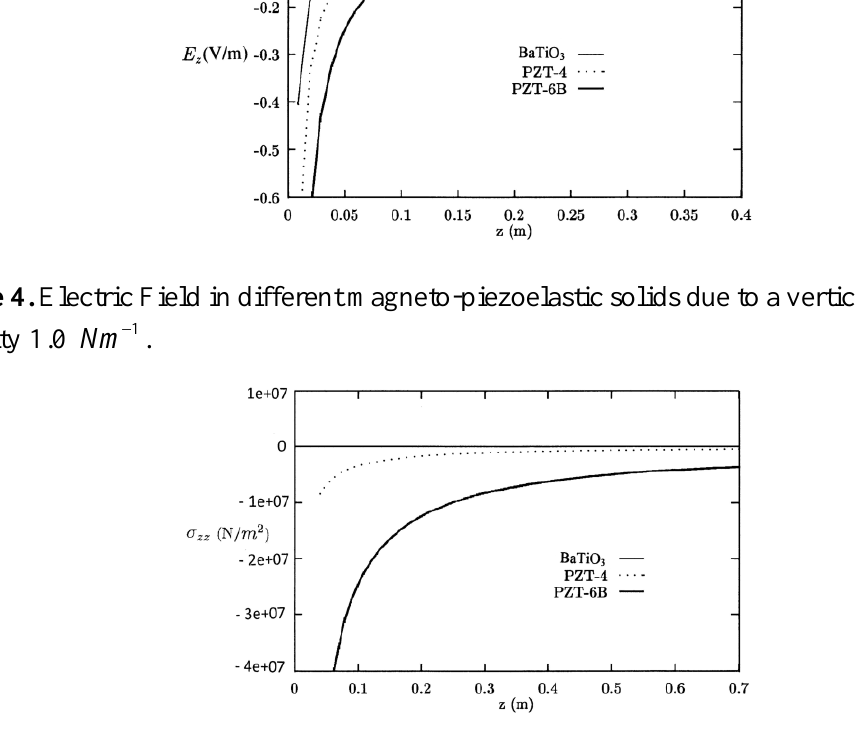
Figure 5. Vertical stress in different magneto-piezoelastic solids due to a line electric charge of intensity